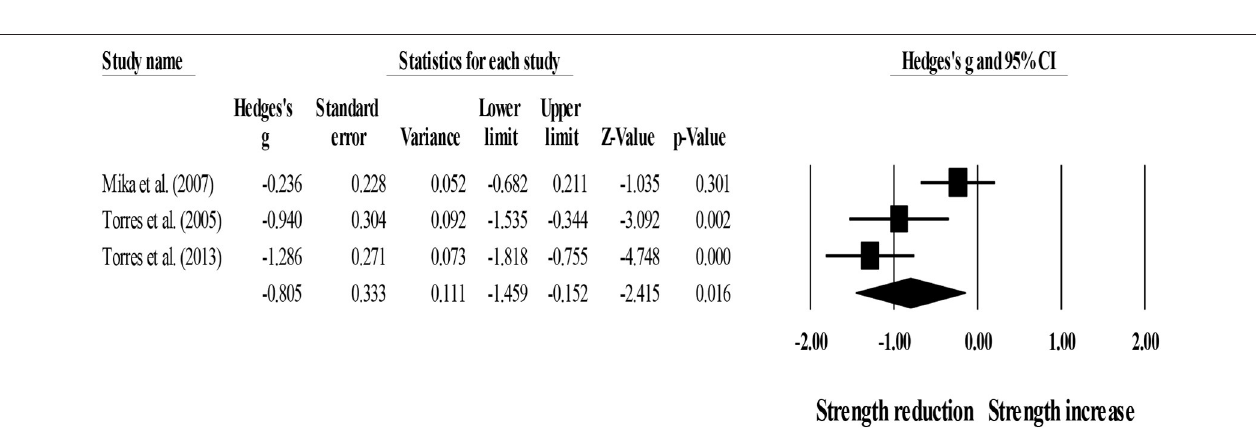
FIGURE 3 | Forest plot denoting short-term strength recovery level in participants that completed post-exercise stretching protocols. Values shown are effect sizes (Hedges’s g) with 95% confidence intervals (CI). The size of the plotted squares reflects the statistical weight of each study. The black diamond reflects the overall result. Note: negative values denote that post-exercise stretching protocols did not allow participants to recover their basal strength level (i.e., 0.00 in the figure).